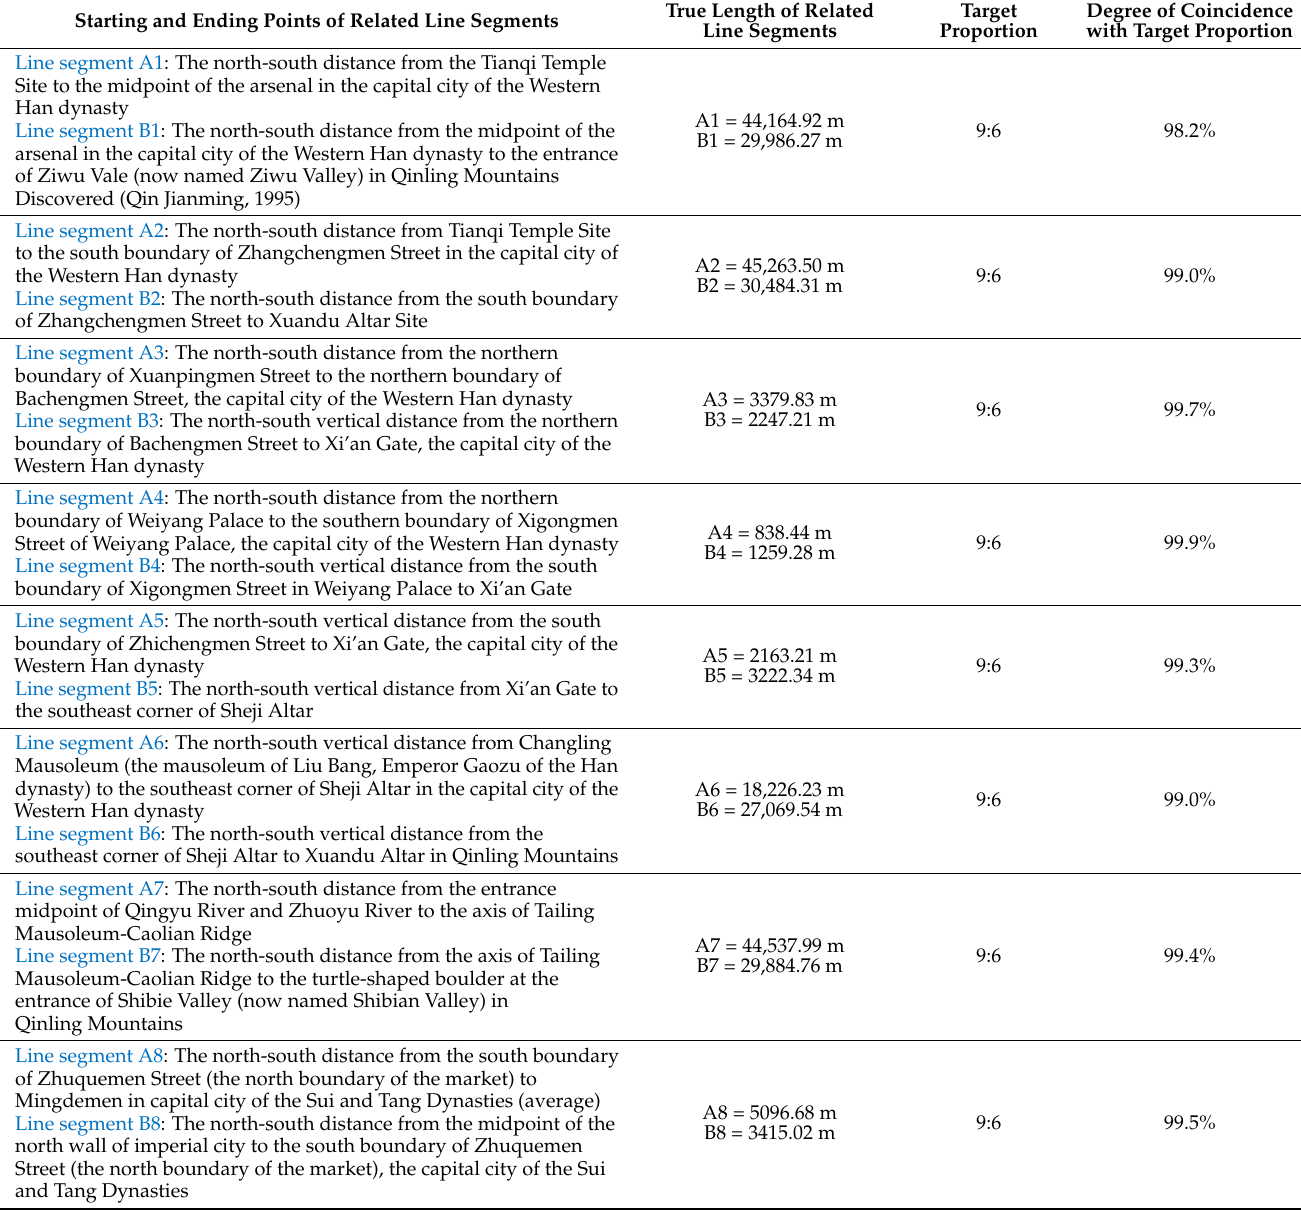
Table 5. Proportional analysis data table of Chinese capitals of the Western Han dynasty as well as the Sui and Tang